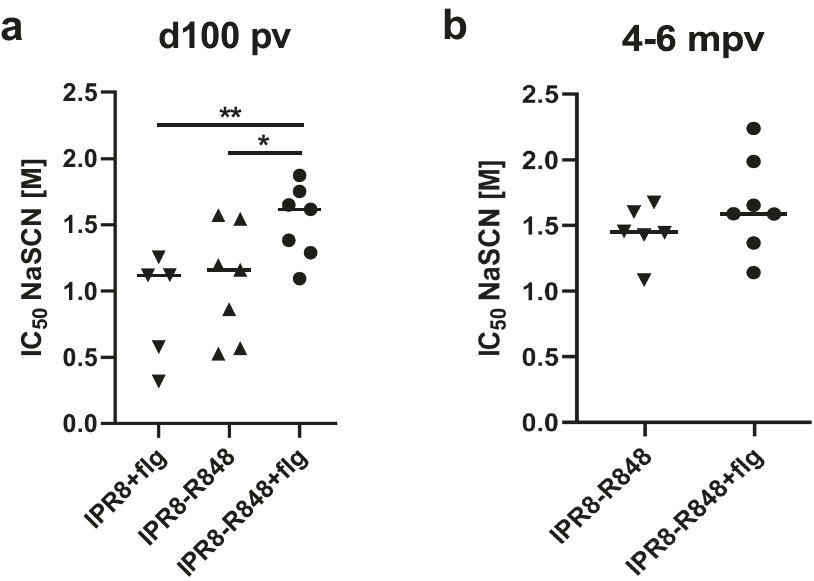
Fig. 3 Adjuvant selection regulates avidity maturation of stem-binding IgG. The average avidity of Ca09 stem-speci fi c IgG at day 100 p.v. ( a ) and 4-6 months p.v. ( b ) was calculated by determining the NaSCN concentration that resulted in a 50% reduction in absorbance compared to the untreated sample. Statistical signi fi cance was determined by ordinary one-way ANOVA with uncorrected Fisher ’ s LSD test for multiple comparisons ( a ) or unpaired t -test ( b ). * p < 0.05, ** p <